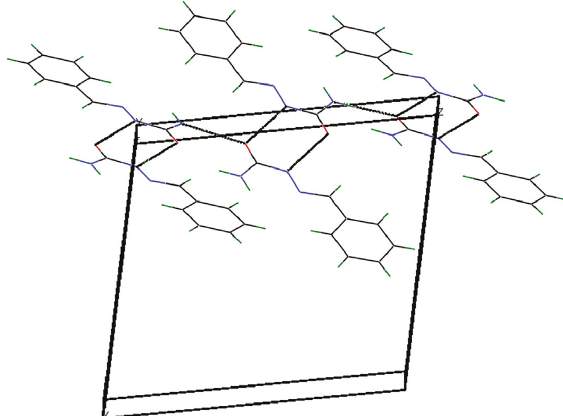
Figure 5: The BDSC’s b-axis packing diagram.